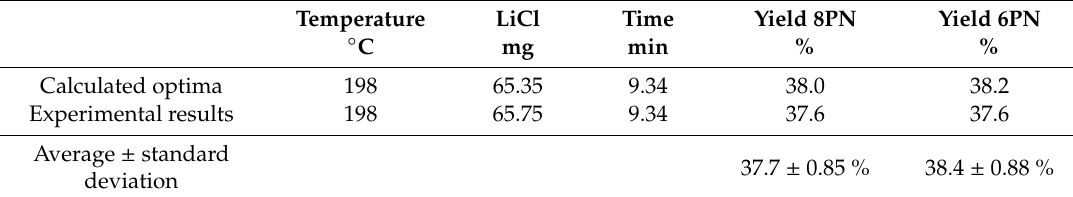
Table 4. Comparison of the calculated with measured values at optimal